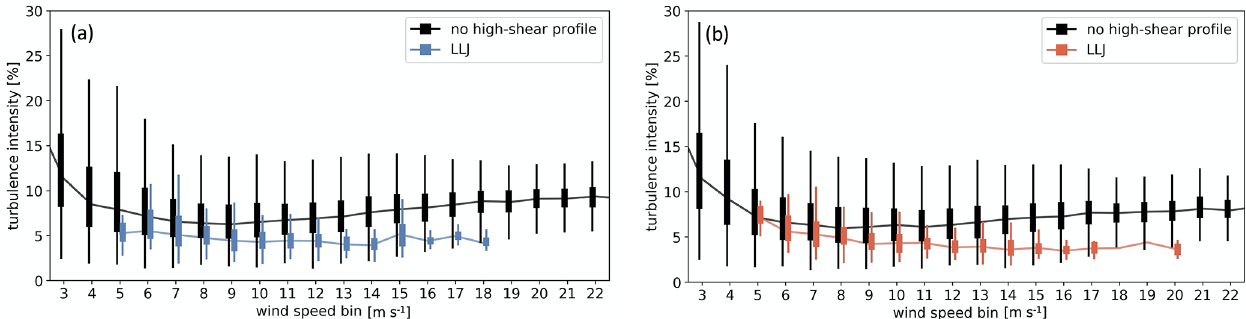
Figure 13. Hub height ( z = 100m) distribution of turbulence intensity for wind speed bins between 3 and 22ms − 1 for the NE (a) and SW (b) buoys. Distributions are shown separately for all 10min periods without a high-shear profile (black) and those with an LLJ profile (colored). Only wind speed bins with at least 10 LLJ profiles are shown. Monotonic-shear periods are excluded here for